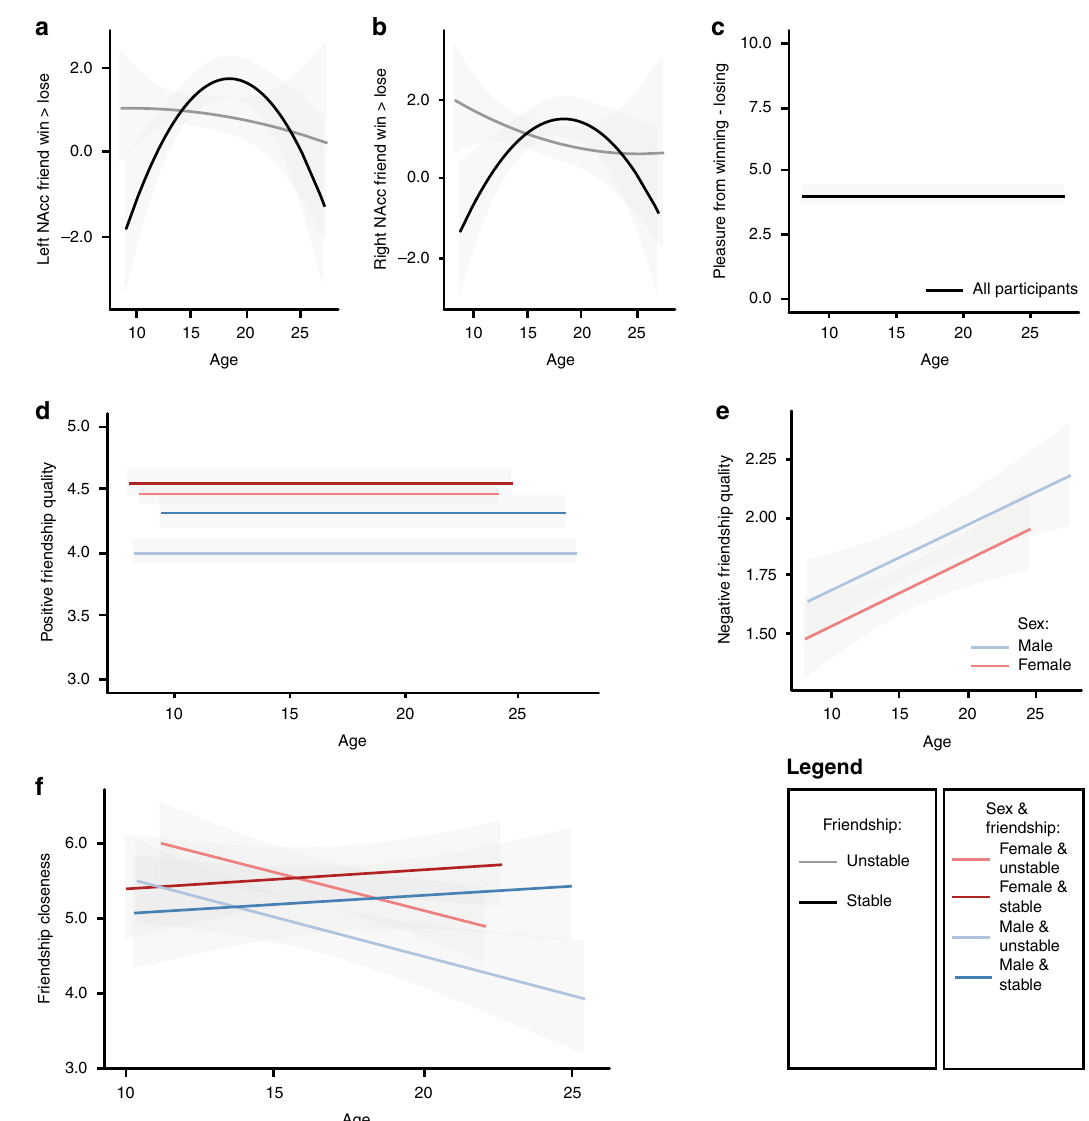
Fig. 1 Effects of age, sex, and friendship stability. Data were analyzed with mixed-models with the following outcome variables. a Left NAcc activity ( n = 123, 346 data points). b Right NAcc activity ( n = 123, 346 data points). c Pleasure from winning activity ( n = 123, 363 data points). d Positive friendship quality ( n = 123, 360 data points). e Negative friendship quality ( n = 123, 359 data points). f Friendship closeness ( n = 122, 222 data points). Solid lines represent predicted values of the best fi tted model (if not speci fi ed in the subpanel, the “ legend ” explains the color features). The gray ribbon shows the 95% con fi dence